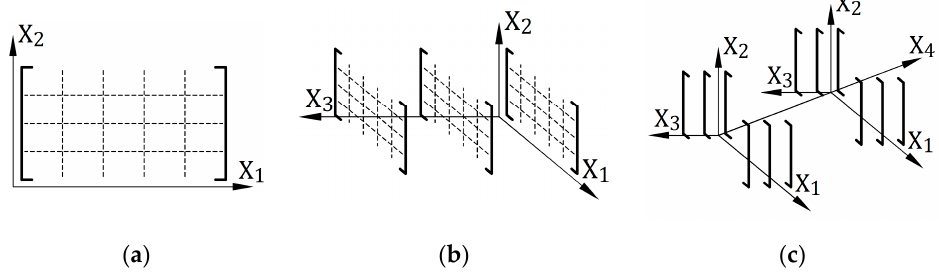
Figure 28. Matrix description of material parameters based on the number of variables: ( a ) two variables—used in the examples in this paper; ( b ) three variables; ( c ) four variables.